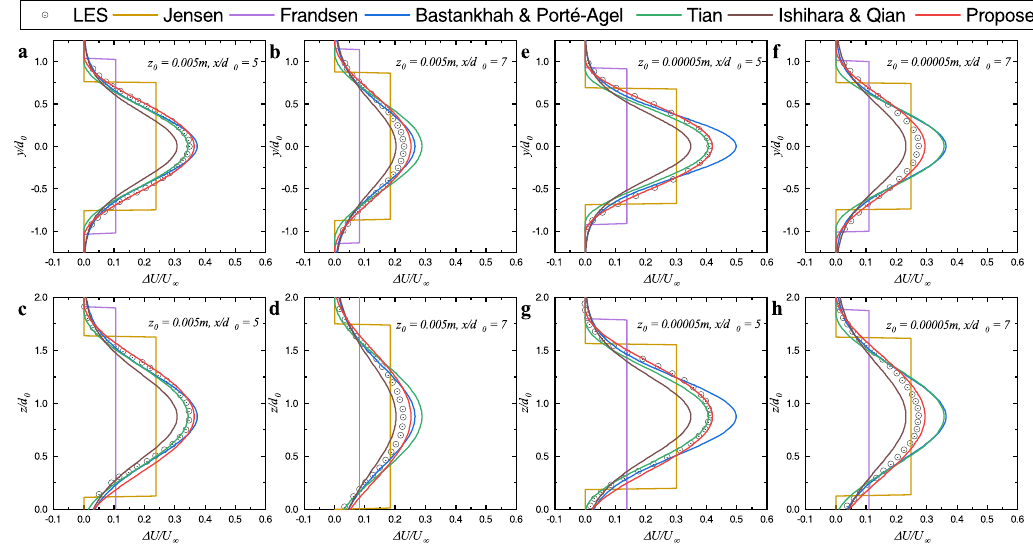
Figure 9. Comparison between the numerical simulation data and the predicted normalized velocity deficit in horizontal (top) and vertical (bottom) profiles: ( a ) z 0 = 0.005m, x / d 0 = 5 (horizontal); ( b ) z 0 = 0.005m, x / d 0 = 7 (horizontal); ( c ) z 0 = 0.005m, x / d 0 = 5 (vertical); ( d ) z 0 = 0.005m, x / d 0 = 7 (vertical); ( e ) z 0 = 0.00005m, x / d 0 = 5 (horizontal); ( f ) z 0 = 0.00005m, x / d 0 = 7 (horizontal); ( g ) z 0 = 0.00005m, x / d 0 = 5 (vertical); ( h ) z 0 = 0.00005m, x / d 0 = 7